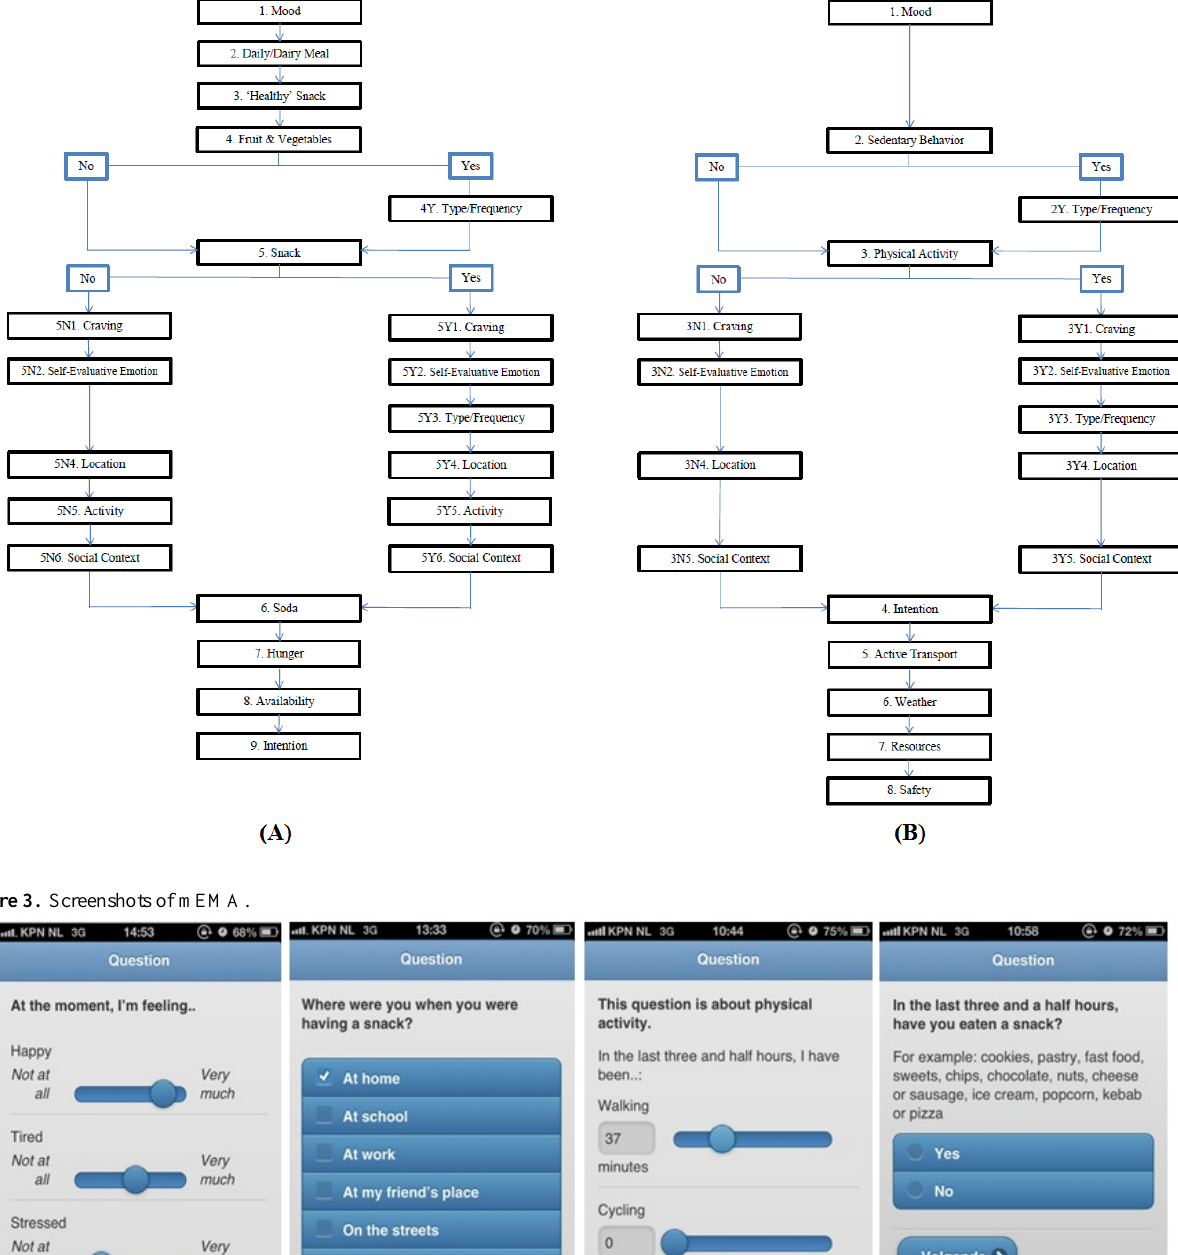
Figure 2. Decision trees of the mEMA app DI and PA questionnaire.